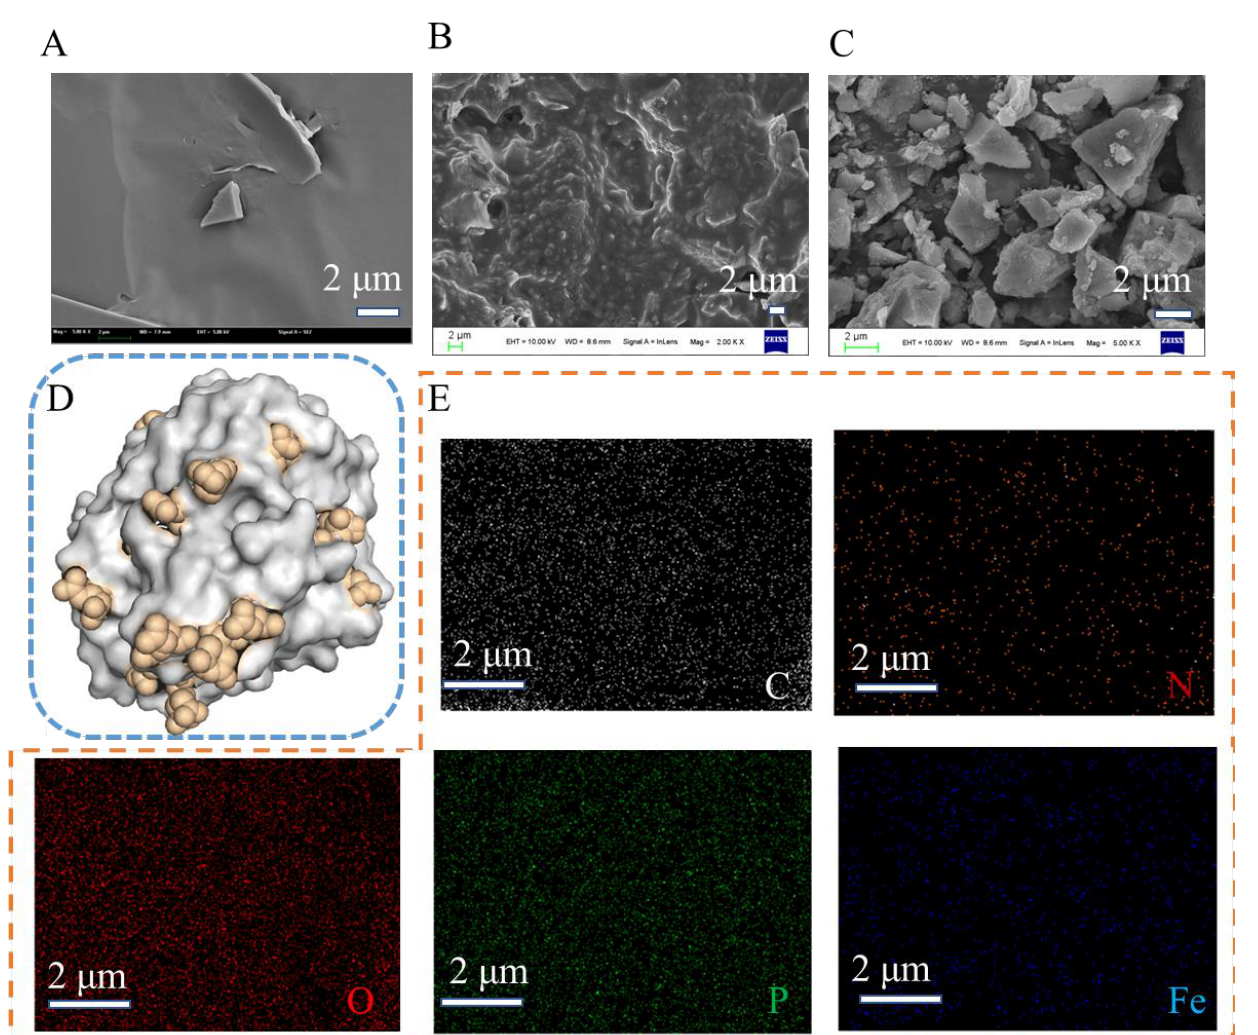
Figure 4. FE-SEM images of DhaA powder ( A ), inorganic carrier ( B ), and immobilized DhaA ( C ). Predicted residues involved in biomineral nucleation are presented as yellow spheres for Fe 3+ ; the images were created using Pymol 2.2 ( D ). EDX elemental mapping of the immobilized DhaA (all elements, C, N, O, P, and Fe) ( E ).